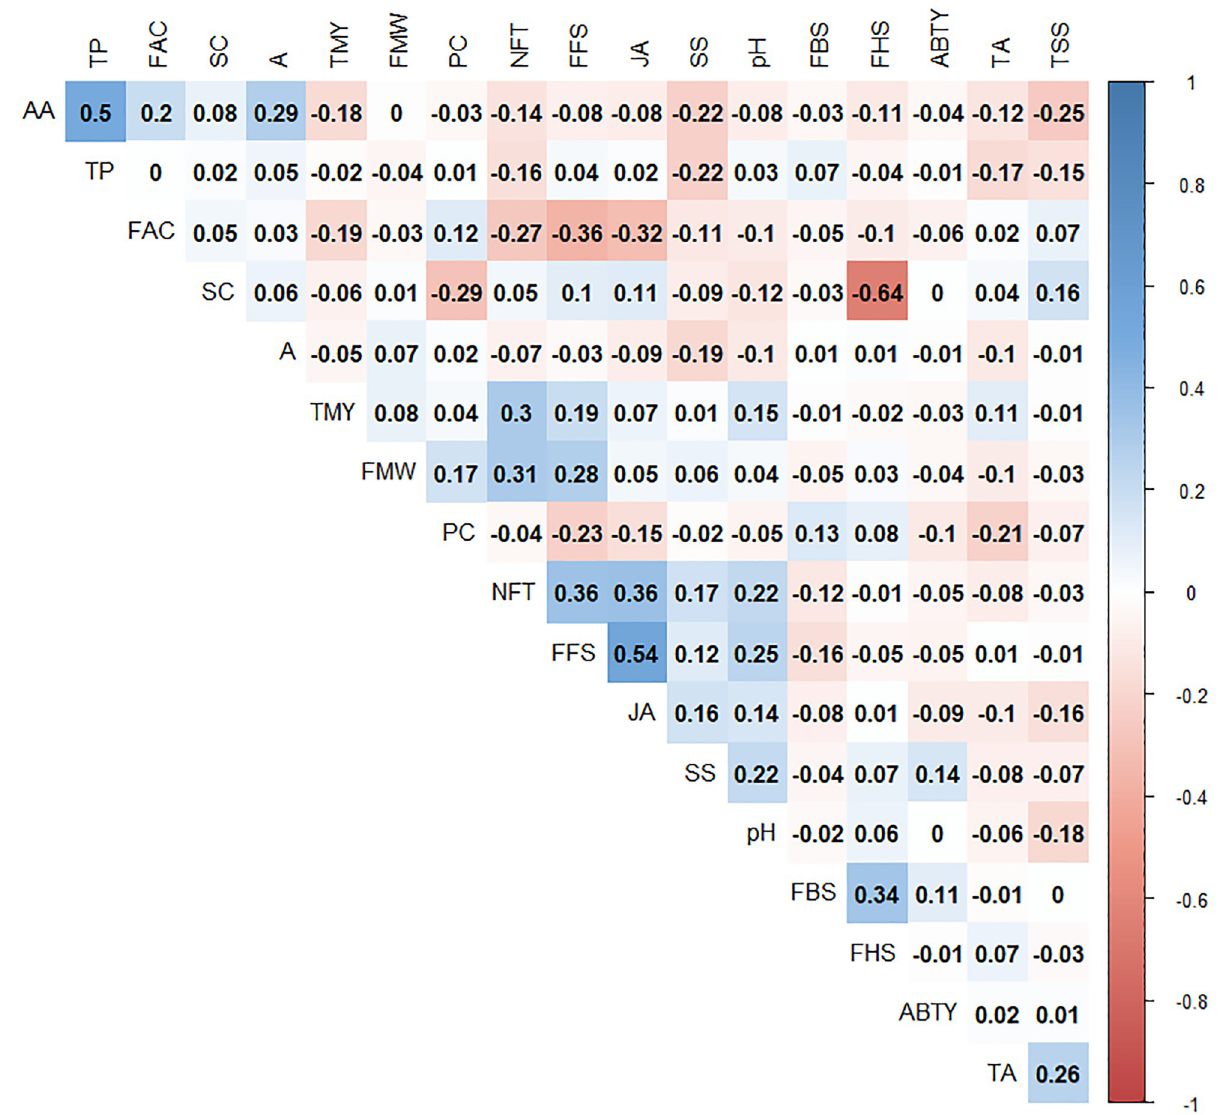
Fig 4. Spearman correlation matrix of the traits. Large circles display strong correlations and small circles represent weak correlations. Only significant correlations are shown (p value < 0.05).